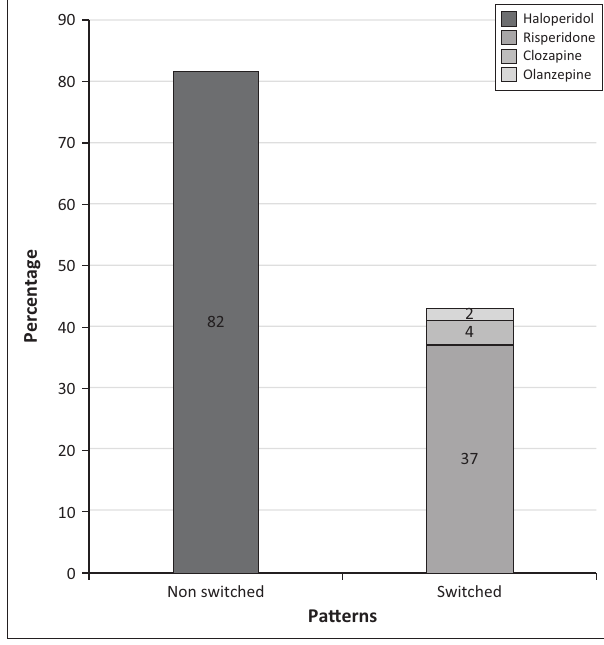
FIGURE 1: Antipsychotic initiated on admission.